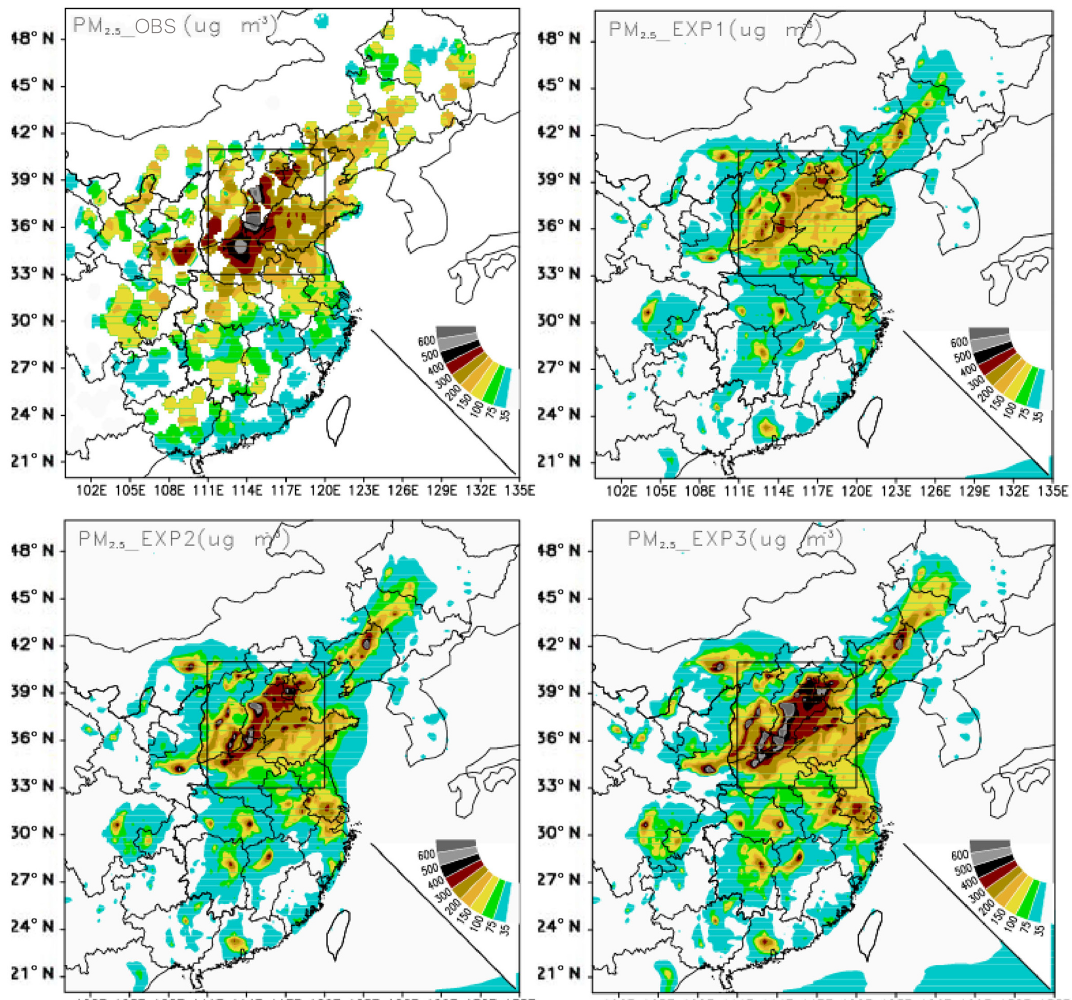
Figure 4. Mean observed (PM 2 . 5 _ OBS) and modelled PM 2 . 5 concentration (µg − 1 m − 3 ) of the PM 2 . 5 explosive growth stage, from the results of EXP1, EXP2, and EXP3 (PM 2 . 5 _EXP1, PM 2 . 5 _EXP2, and PM 2 . 5 _EXP3,